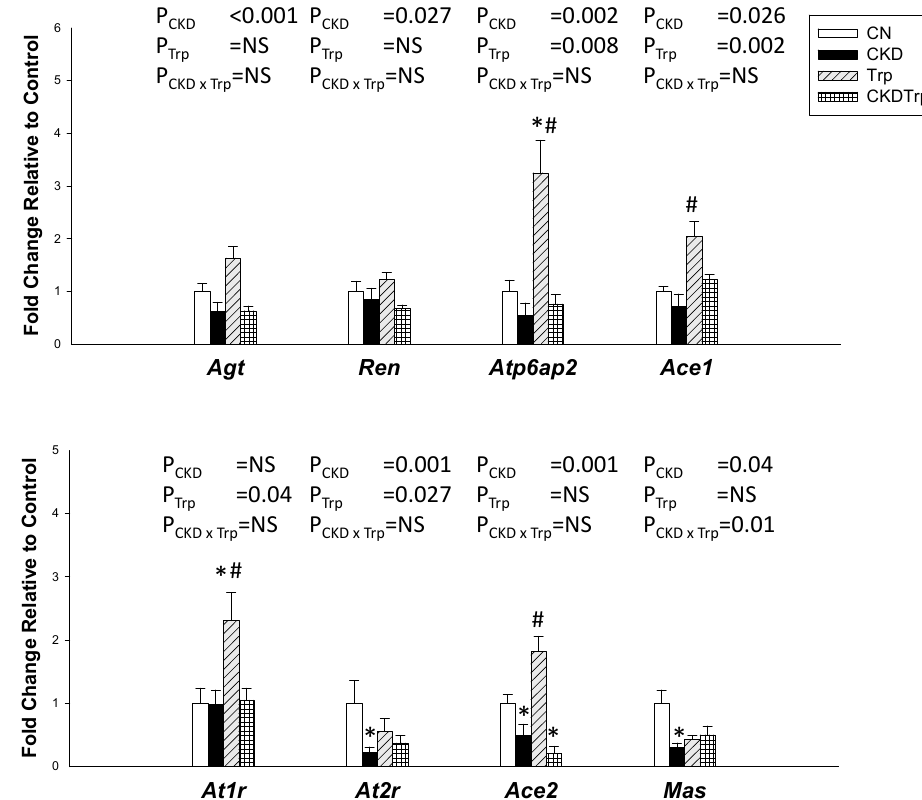
Figure 3. Effects of maternal adenine-induced chronic kidney disease (CKD) and tryptophan supplementation (Trp) on the renin-angiotensin system in offspring kidneys at 12 weeks of age. Data are shown as means ± S.E.M. A two-way ANOVA with a Tukey’s post hoc test was performed for statistical analysis. CKD × Trp = interaction of CKD and Trp. * p < 0.05 vs. CN. # p < 0.05 vs. CKD. n = 8/group.